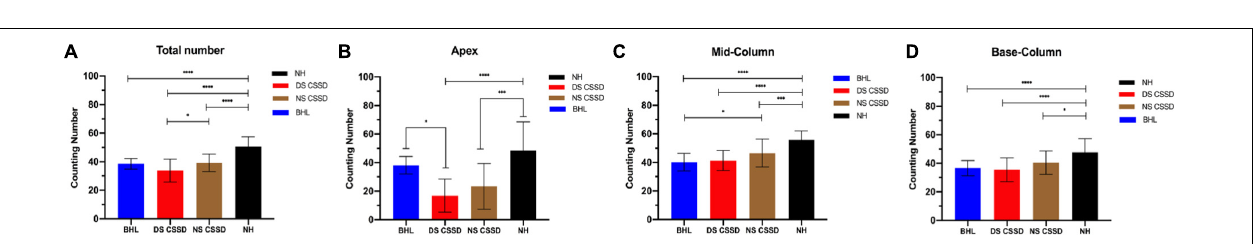
FIGURE 8 | Spiral ganglion cell counting at P30. (A) Averaged total ganglion cell counting number from the apex to base turns. (B) Ganglion cell counting number in the apex turn in different hearing phenotypes. (C) Ganglion cell counting number in the mid turn in different hearing phenotypes. (D) Ganglion cell counting number in the base turn in different hearing phenotypes. * p < 0.05, ** p < 0.01, *** p < 0.001, **** p <